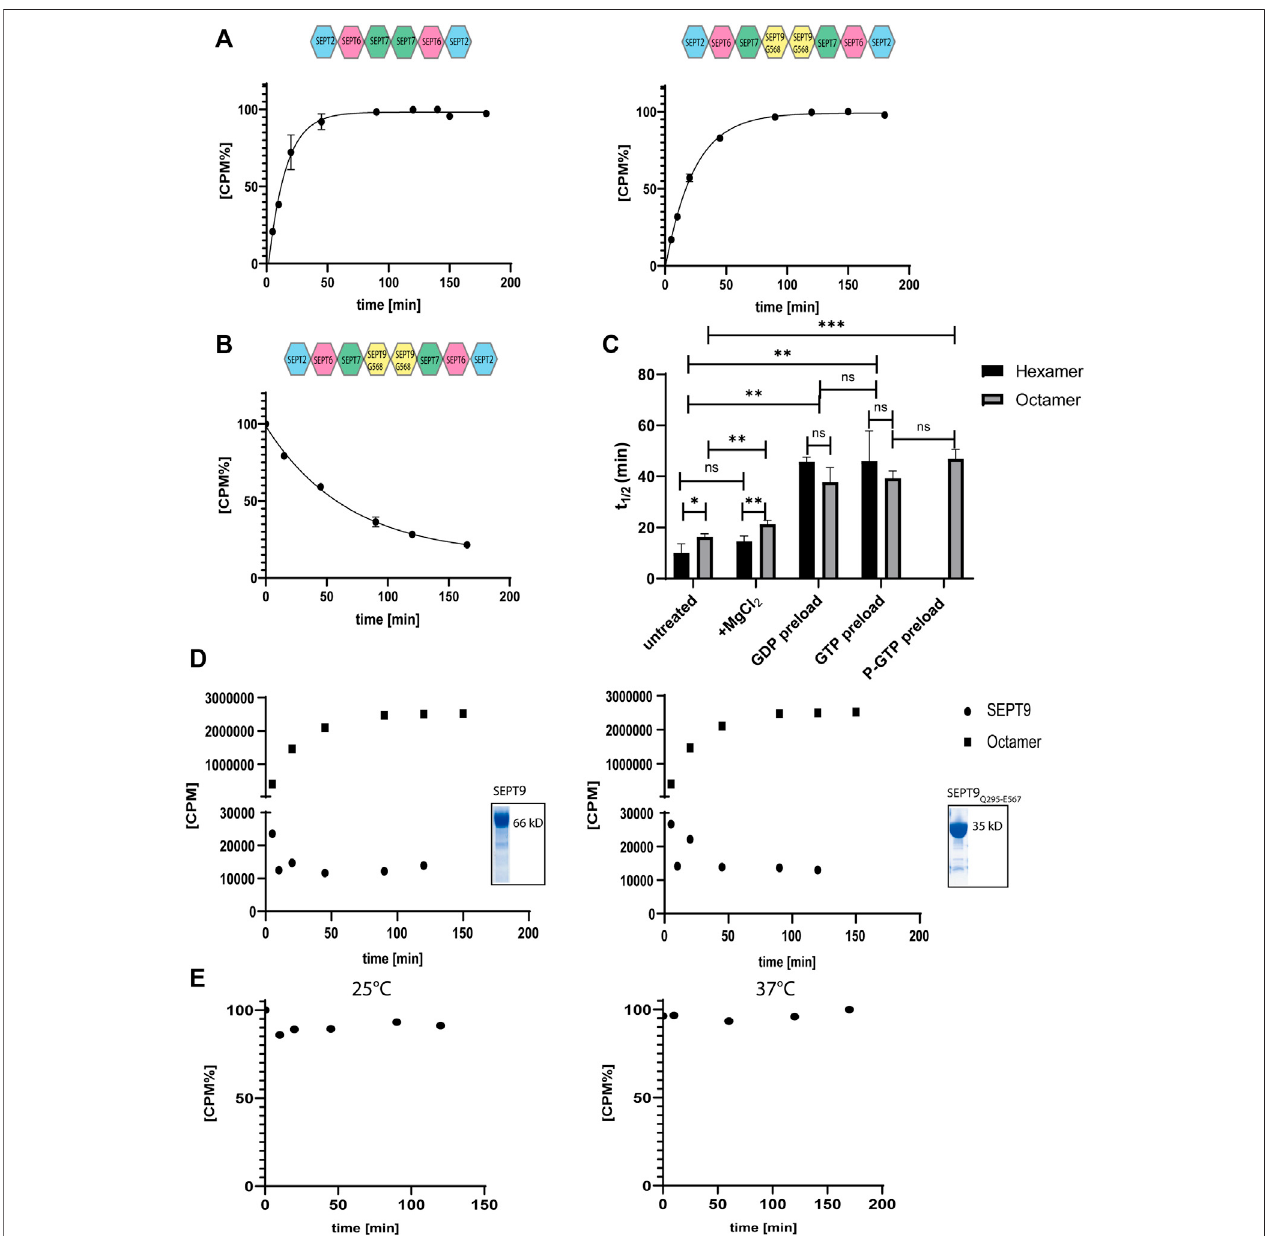
FIGURE 4| Nucleotide uptake- and hydrolysis properties of hexameric and SEPT9 G568 octameric septin rods. (A) Nucleotide exchange reaction of hexameric (left panel) and octameric septins (right panel). Puri fi ed complexes were incubated with [ γ 32 P]-GTP and uptake was monitored at the indicated timepoints by a fi lter assay. [CPM%] values (normalized radioactive counts) are plotted vs. the reaction time. The connecting line represents the fi tting curve of the exponential association. (B) Nucleotide exchange reaction of octameric septins preloaded with [ γ 32 P]-GTP. The preloaded complex was incubated with GTP and decrease of [ γ 32 P]-GTP was monitored at the indicated timepoints by a fi lter assay as in A. The connecting line represents the fi tting curve of the exponential dissociation. (C) Compilation of the t 1/2 valuesofallperformednucleotideexchangeassays.Theparametersofthestatisticalevaluationareprovidedin SupplementaryTablesS2,S3 .Errorbarsrepresentthe standard deviation. All assays [including those depicted in detail in (A,B)] were performed at least in triplicate. (D) Representative [ γ 32 P]-GTP uptake assay for isolated SEPT9 FL (left panel) and SEPT9 Q295-E567 (right panel) subunits. The assay was performed as in (A). The raw, unprocessed CPM counts are plotted vs. the reaction time. Forcomparison,arepresentativenucleotideuptakereactionforaseptinoctamerisalsoplotted.TheinletsshowtheCoomassiestainedSDS-PAGEofbothpuri fi cations. (E) RepresentativeGTPhydrolysisassayforoctamericseptins.Afterpreloadingwith[ γ 32 P]-GTP,thecomplexwassubjectedtohydrolysisconditionsapplicableforsmall GTPases. The reaction was performed at 25 ° C (left panel) and 37 ° C (right panel). Samples were taken at the indicated time points and the [ γ 32 P]-GTP content was detected by a fi lter assay. [CPM%] values (normalized radioactive counts) are plotted vs. the reaction time. GTP hydroloysis of hexameric rods is shown in Supplementary Figure S4